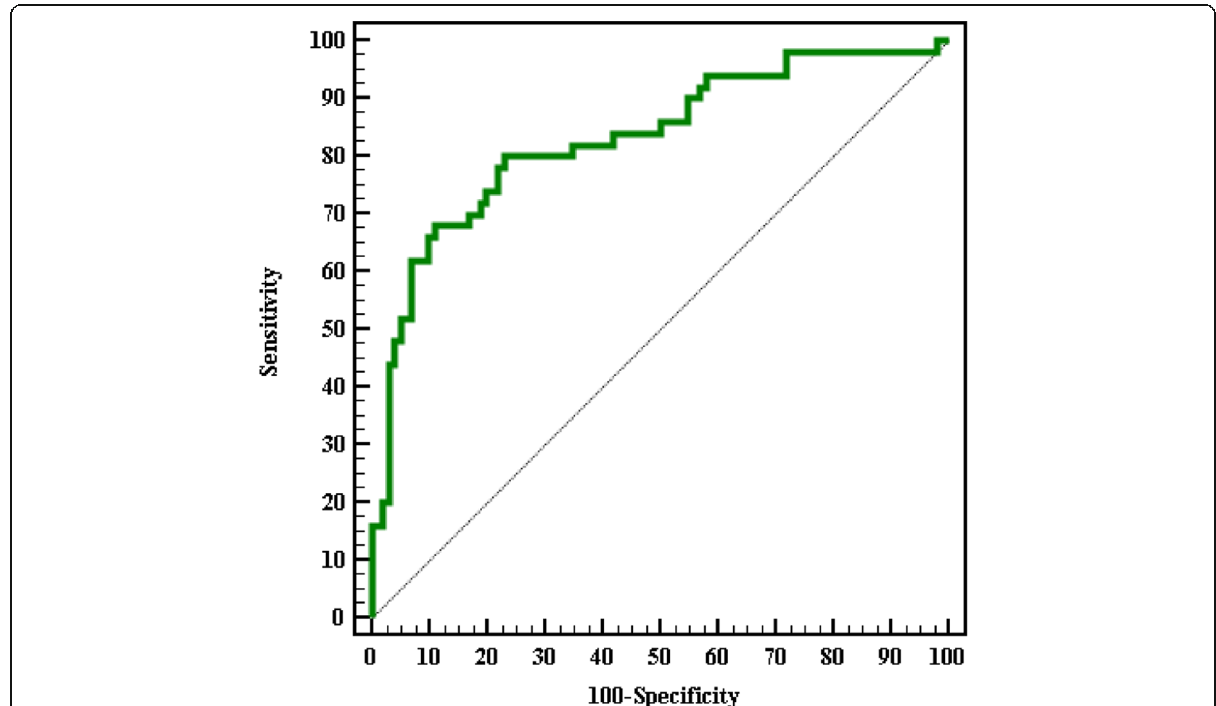
Fig. 5 ROC curve for the combination of AFP and miR-23b-3p to predict early-stage HCC patients (group II) from HCV-related cirrhosis (group I)